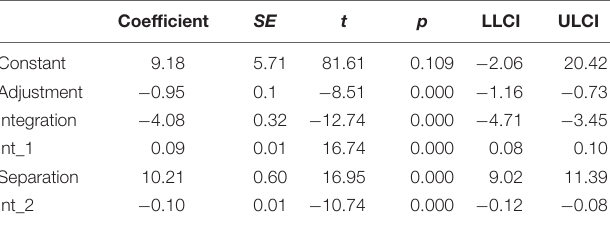
TABLE 3 | Moderation model for study 1 (work-related anxiety).